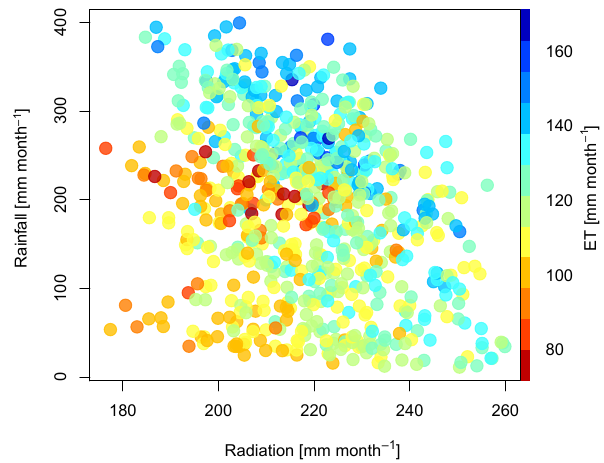
Figure 5. Scatterplot of monthly radiation and rainfall for the five sub-basins. Colour gradient indicates the monthly ET value, from high (blue) to low